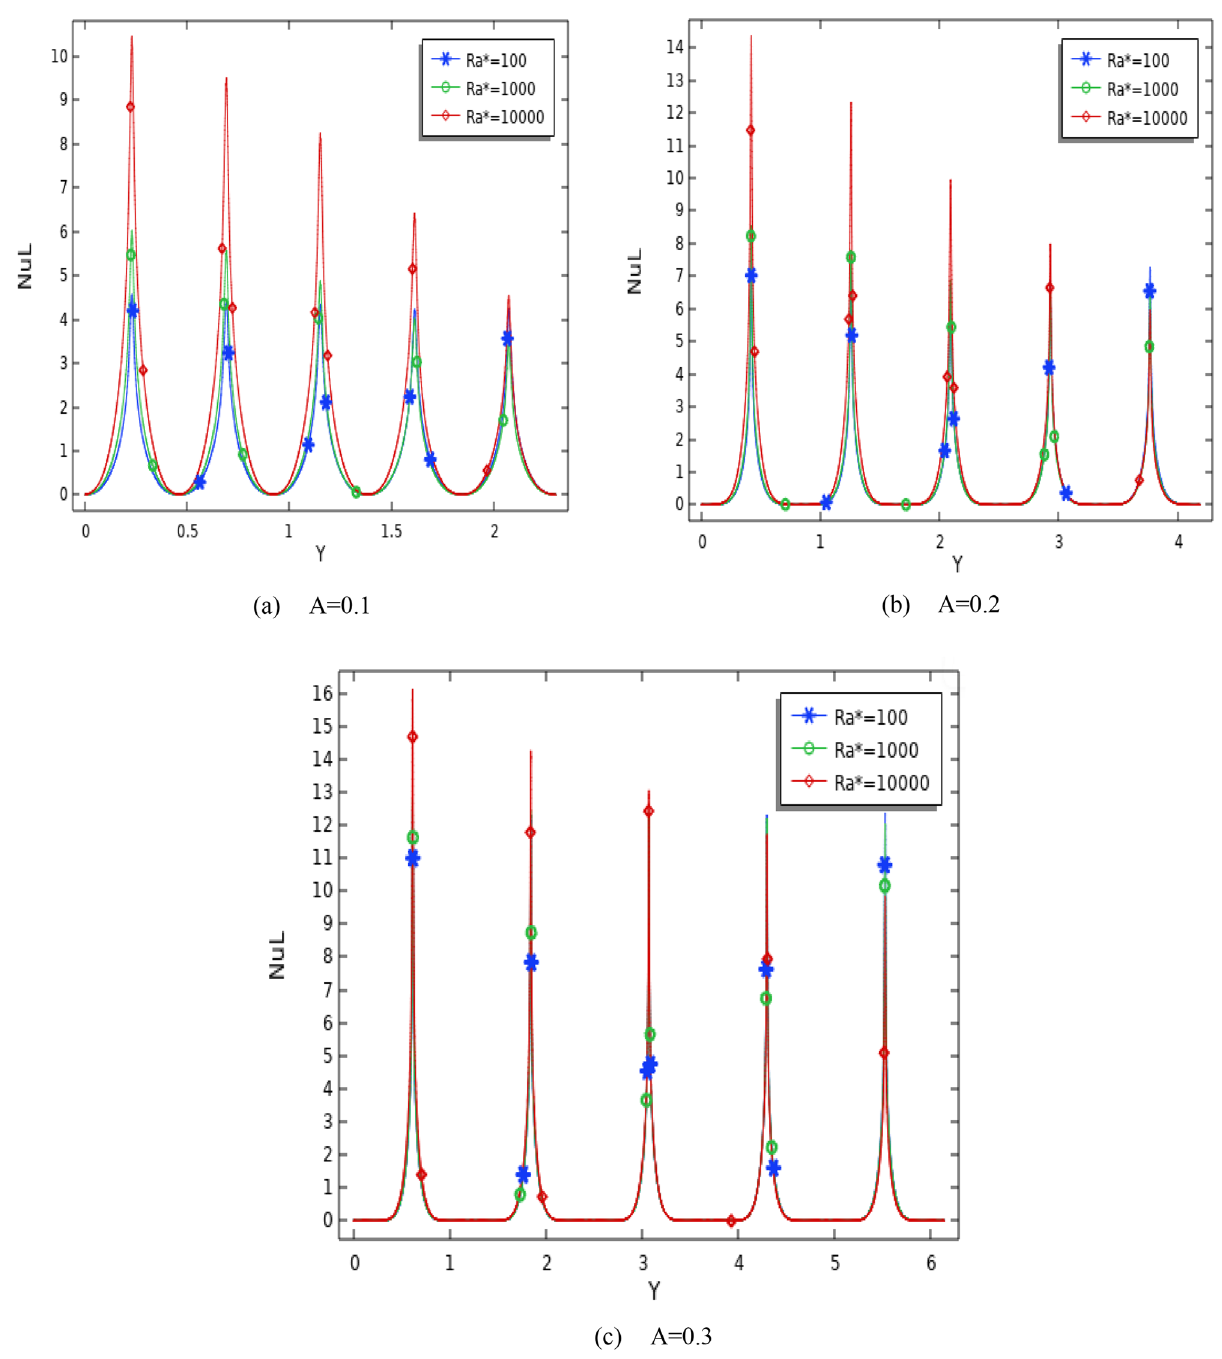
Figure 8. Difference of Local Nusselt number with hot wavy wall for different Ra* and Da at number of waves (N = 5), ϕ = 0.01, and ( a ) A = 0.1, ( b ) A = 0.2, and ( c ) A = are shown in Fig. 12 , at A = 0.1, ϕ = 0.01, and N = (1, 3, 5, and 7). The impact of N also improves by increasing the Ra*. It increases as Ra* increases and reduces with the increase in wave numbers. The heat transfer greatest increase at Ra* = 10 4 at N = 1. Figure 13 shows the effect of Ra* and wave amplitudes on the average amount of Nusselt in N = 1, ϕ = 0.01, and A = (0.2 and 0.3). Maximum improvement of the average Nusselt number is when Ra* increases from 10 2 to 10 4 at Da = 10 –6 and A = 0.2. The impacts of the nanoparticle volume fractions are seen in Fig. 14, at A = 0.1, N = 1. As ϕ rises, the Nu ave increases slightly with Ra* increasing. The greatest improvement in average Nu at Ra* (10 4 ), Da (10 –6 ), and ϕ (0.05) is (40.87%) compared to pure fluid.